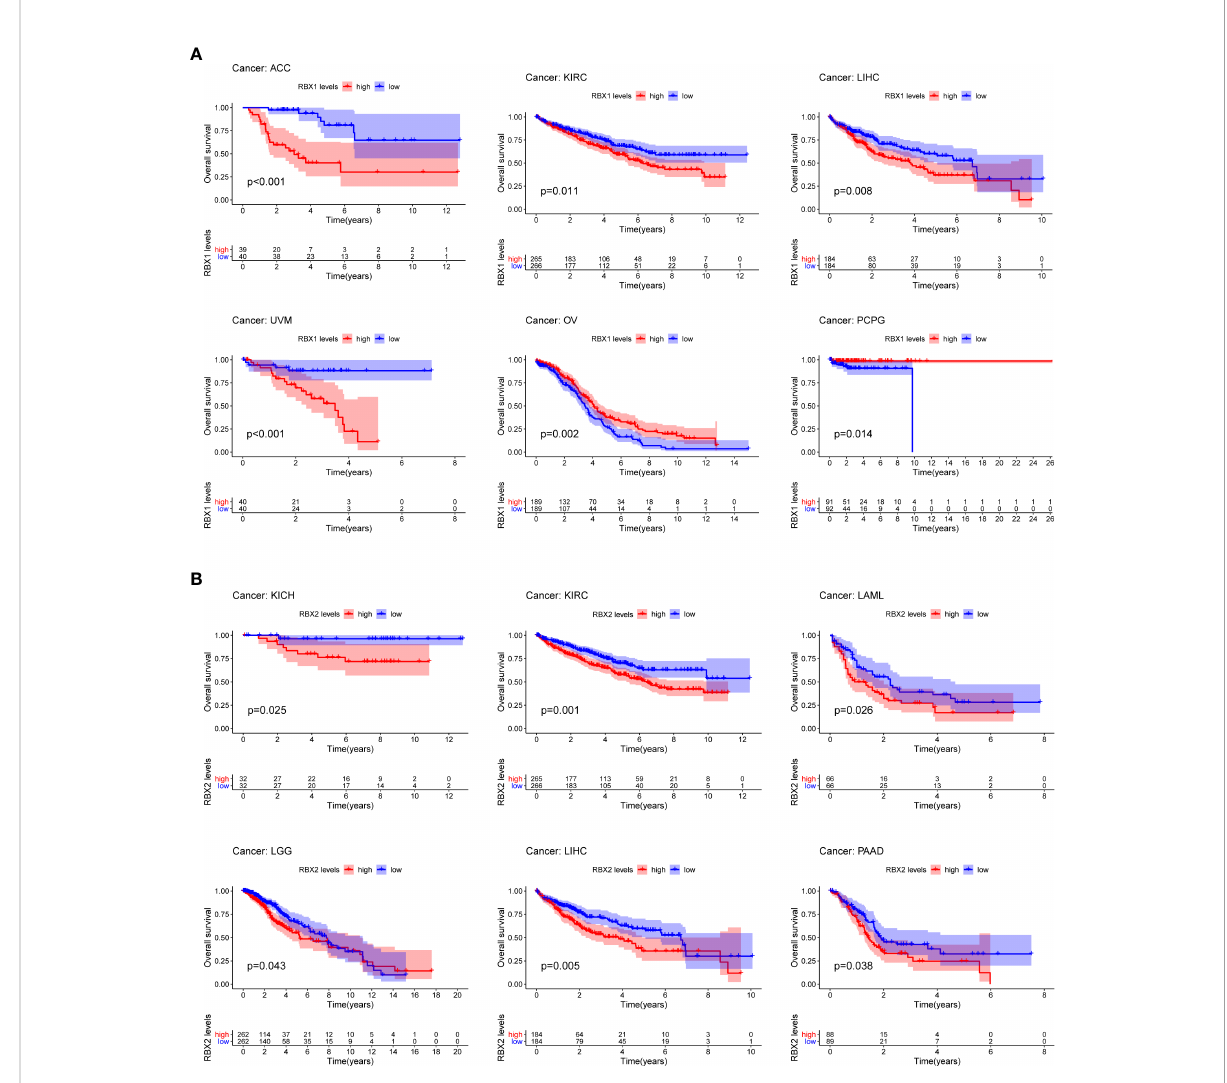
FIGURE 3 Kaplan-Meier survival curves comparison of high and low expression of Ring fi nger family gene in pan-cancer. (A) OS survival curves of RBX1 in different cancers: ACC, p<0.001; KIRC, p=0.011; LIHC, p=0.008; UVM, p<0.001; OV, p=0.002; PCPG, p=0.014. (B) OS survival curves of RBX2 in different cancers: KICH, p=0.025; KIRC, p=0.001; LAML, p=0.026; LGG, p=0.043; LIHC, p=0.005; PAAD,